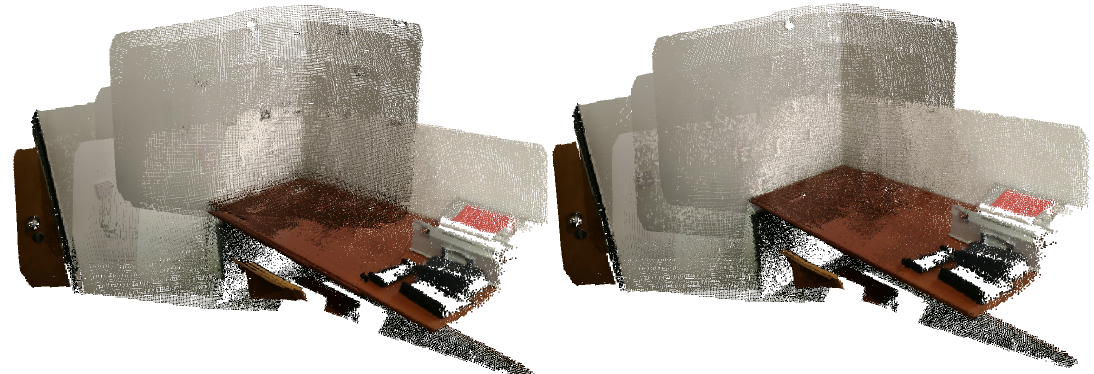
Figure 15. Point cloud coloured with texture obtained from restored images, using cross-inpainting: ( left ) before optimization; ( right ) after